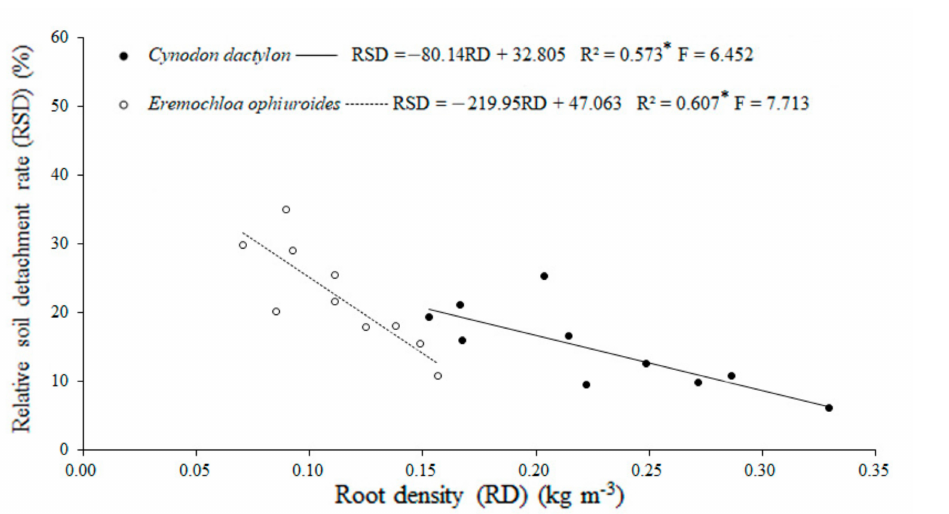
Figure 6. Relationship between root density (RD) and relative soil detachment rate (RSD) at slope 15 ◦ . Significance level: * p <